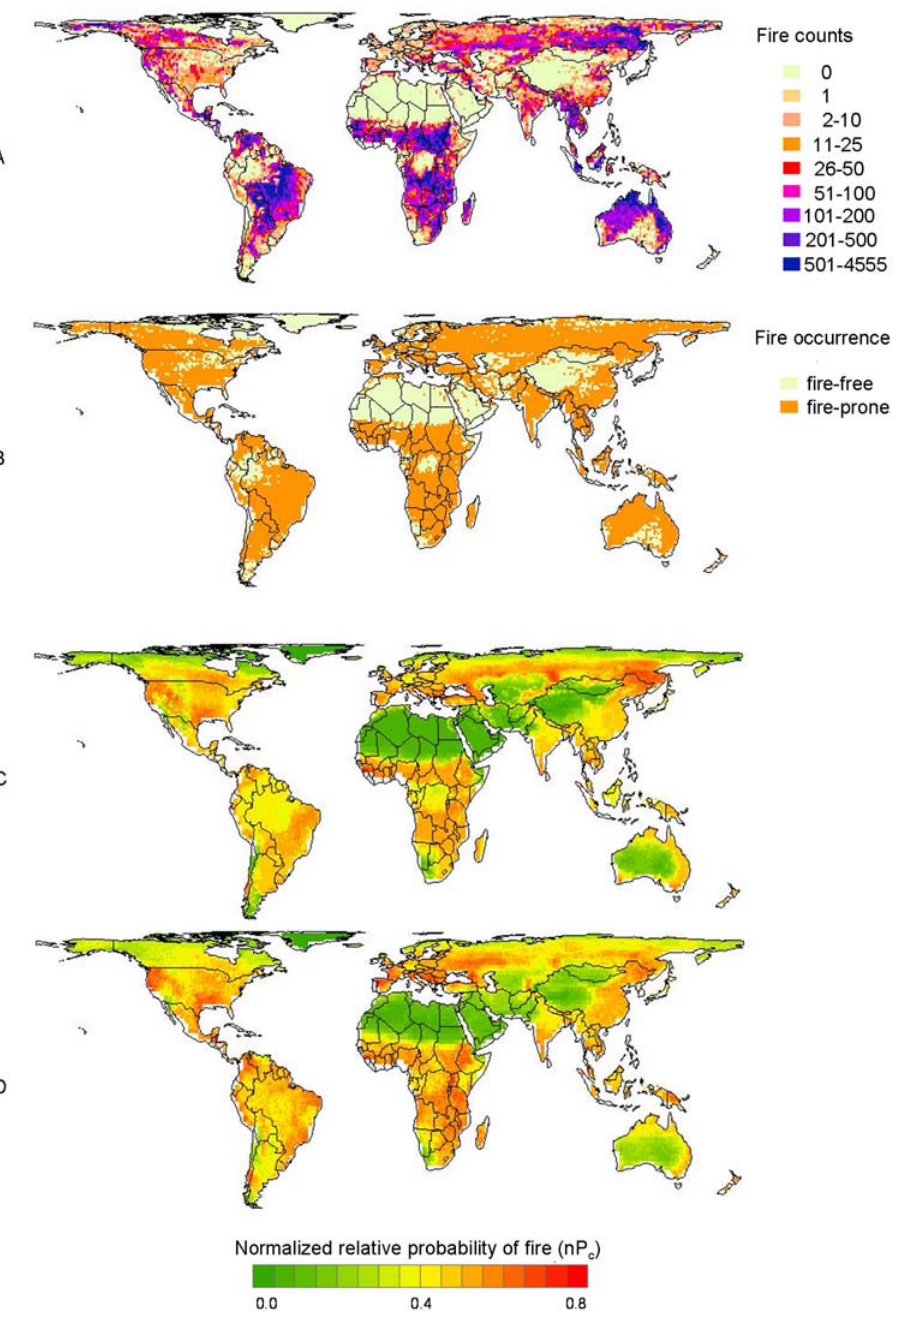
Figure 1. The observed and modeled distribution of fire under current conditions. (A) Cumulative counts of fire activity detected by the Along Track Scanning Radiometer (ATSR) around the world at a resolution of 100 km over 10 years. (B) The same fire data classified to represent fire- prone (orange) and fire-free (yellow) parts of the world; note that areas of white within terrestrial boundaries were clipped from the analyses to match climate data. (C) Mean of normalized relative probability of fire (nP c ) for ten FIRE NPP sub-models of fire-prone parts of the world under current conditions. (D) Mean of normalized relative probability of fire (nP c ) for ten FIRE noNPP sub-models of fire-prone parts of the world under current conditions. doi:10.1371/journal.pone.0005102.g001 and was designed to simulate oceanic and atmospheric climate and GFDL CM2.1 [31] General Circulation Model (GCM) historical variability over a multi-century temporal extent, at a diurnal simulations (1961 to 1990) and from observed climate normals resolution [31]. WorldClim is a dataset of interpolated climate (1950 to 2000) provided by WorldClim to generate statistical surfaces generated using thin-plate smoothing splines from estimates from GAMs (see Regression modeling , below and Text S3, weather station data recorded around the world [30]. The Figure S3). The GFDL CM2.1 is a global coupled climate model GFDL CM2.1 and WorldClim-based models had very similar developed at NOAA’s Geophysical Fluid Dynamics Laboratory